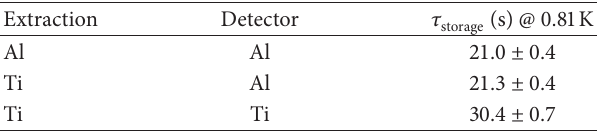
Table 2: Storage time in different configurations. Extraction